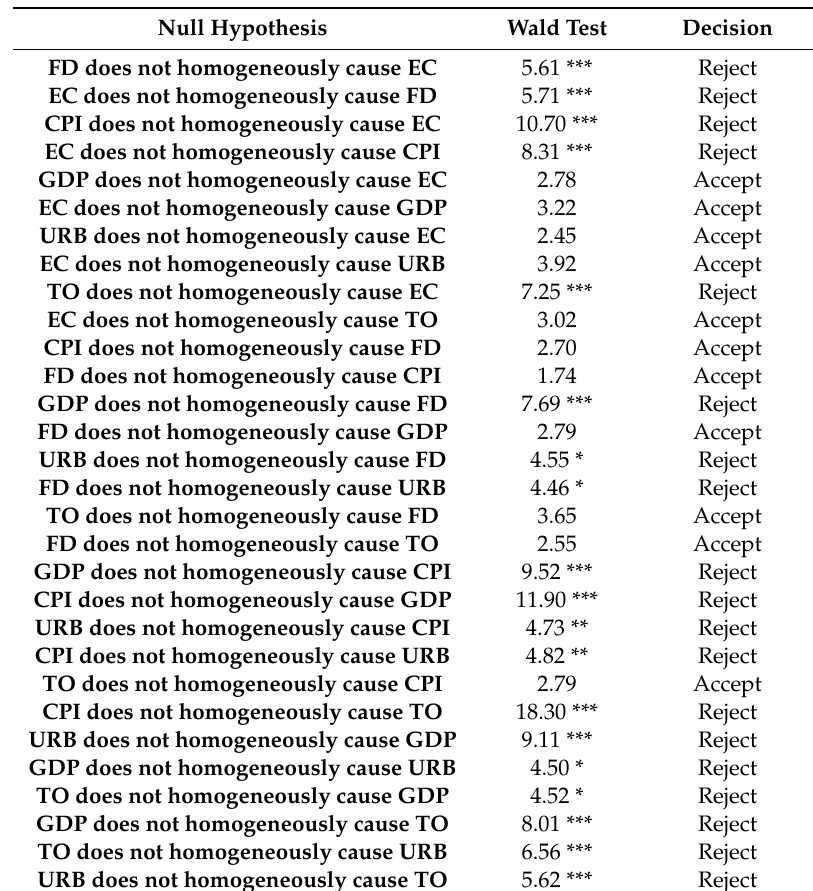
Table 7. Results of the heterogeneous causality